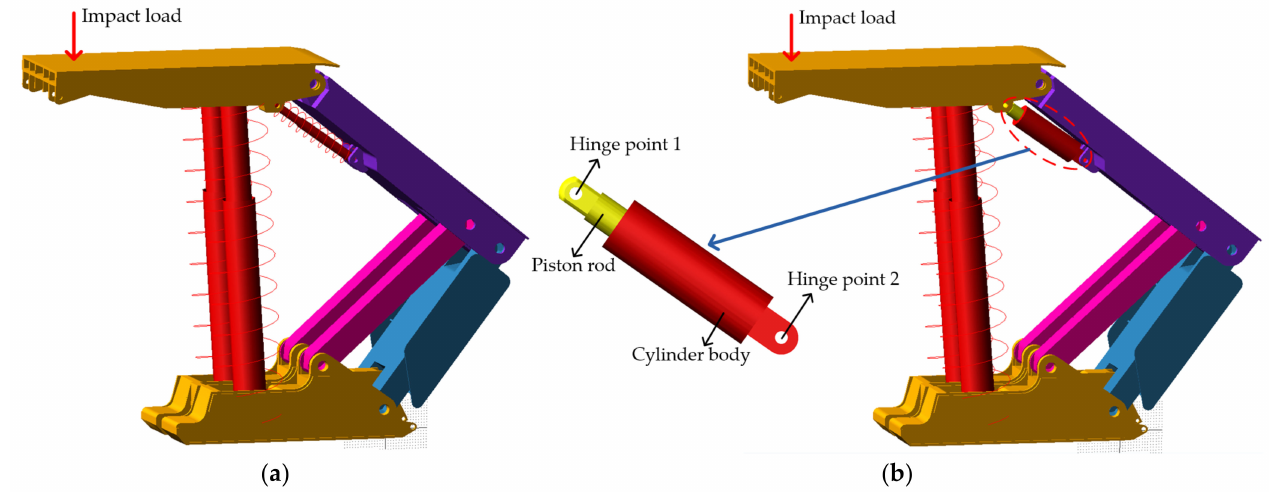
Figure 4. Simulation model diagram: ( a ) simulation model of hydraulic support with the traditional balance jack; ( b ) simulation model of hydraulic support with the novel balance jack.